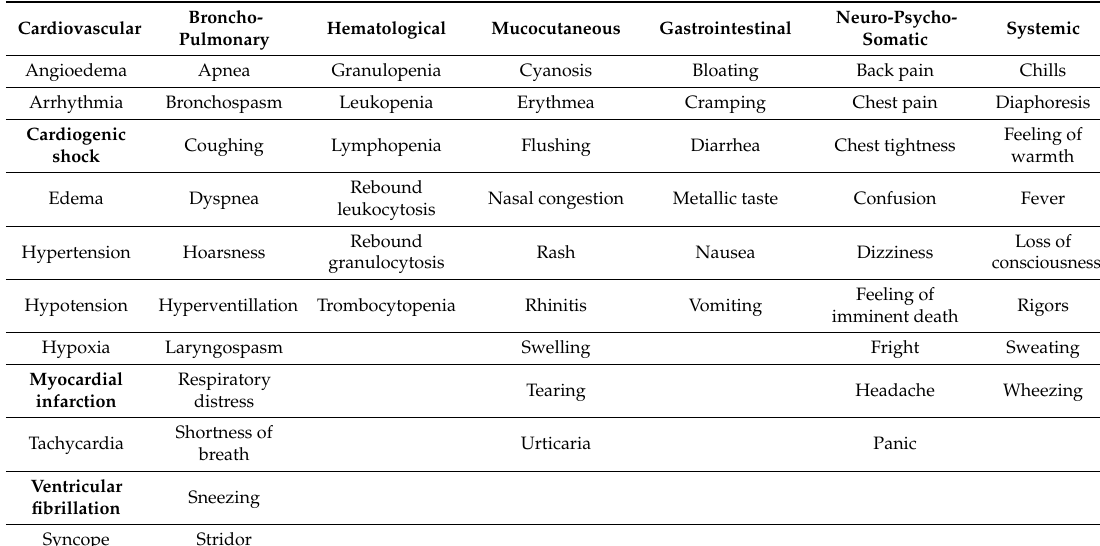
Table 2. Symptoms of pseudoallergy. The most life-threatening symptoms are highlighted in bold [10]. Reprinted from Molecular Immunology, Vol. 61, Szebeni J., Complement activation-related pseudoallergy: A stress reaction in blood triggered by nanomedicines and biologicals, Pages 163–173, Copyright (2014), with permission from